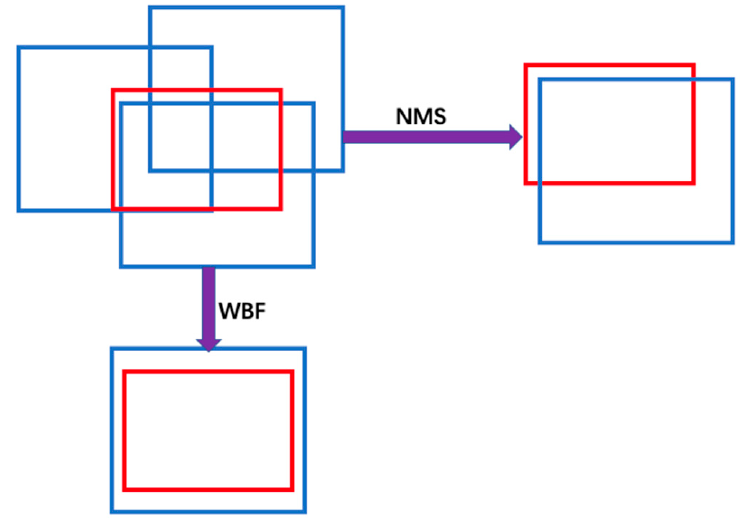
Figure 2. Schematic diagram of WBF and NMS processing multiple prediction results. The red box represents the real red box, and the blue box represents the prediction made by multiple models.